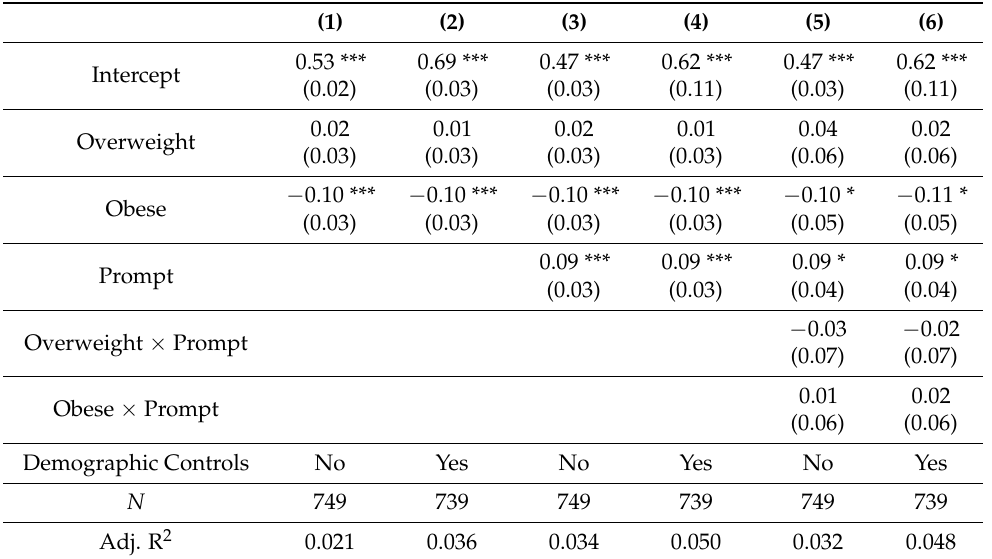
Table 3. Linear probability model of choosing a consideration set that contains healthier